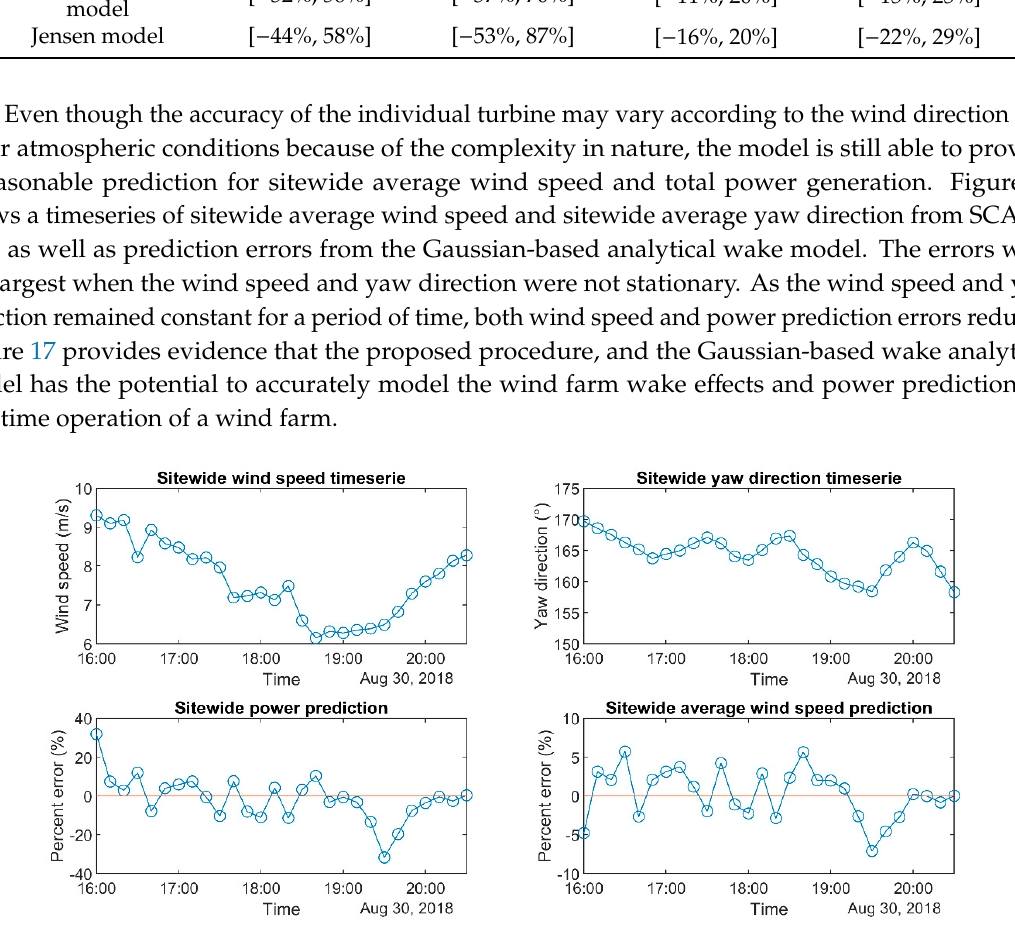
Figure 17. Timeseries of sitewide SCADA data and model prediction errors. The red line is the zero reference line.